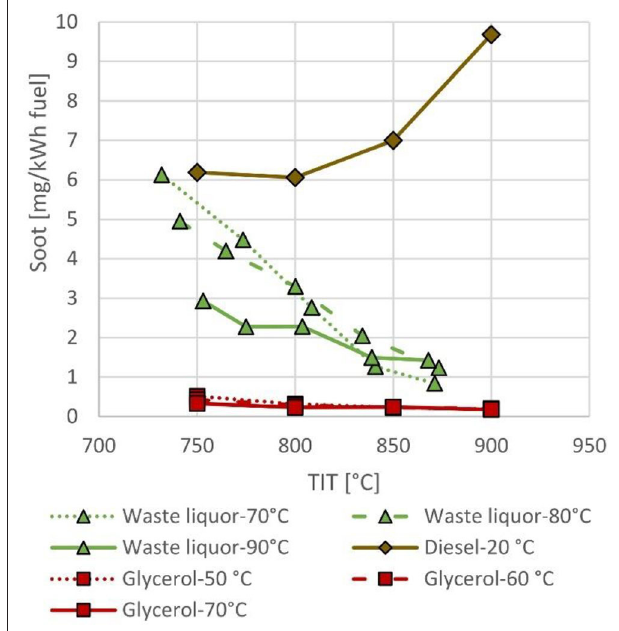
FIGURE 12 | Soot emissions for different fuels at different fuel temperatures.